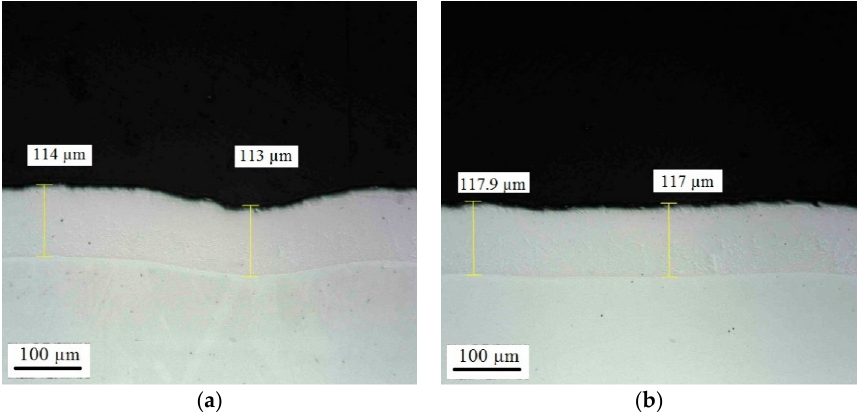
Figure A21. Microscopic images of the cross-section of 316-Cr ( a ) before and ( b ) after the high-temperature corrosive attack after 168 h.